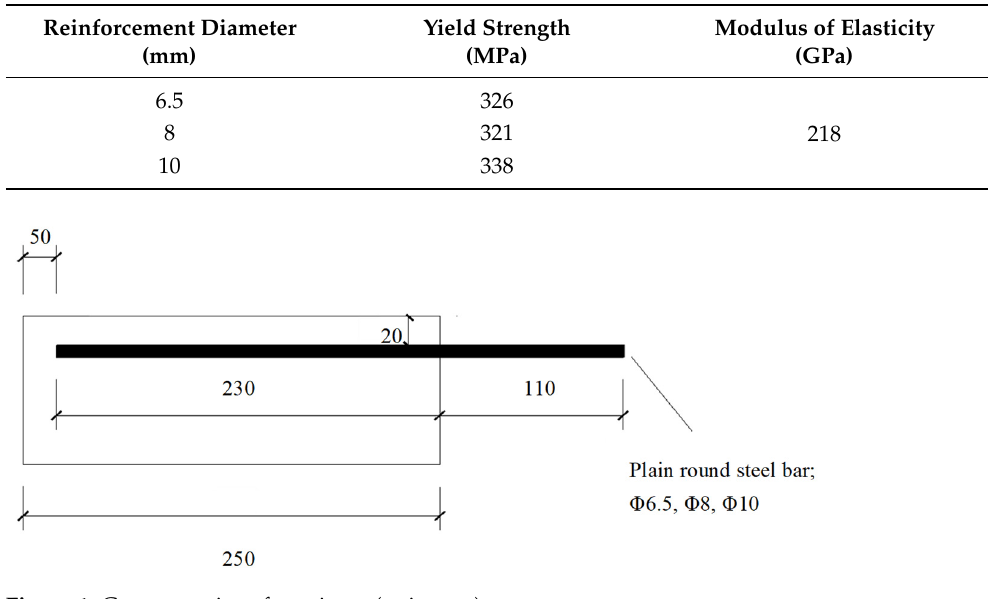
Figure 1. Geometry size of specimen (unit: mm). Table 2. Parameters and results of specimens.